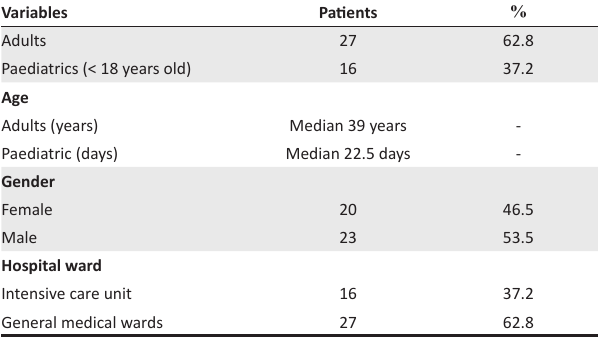
TABLE 1: Demographic data of patients in study ( n = 43).